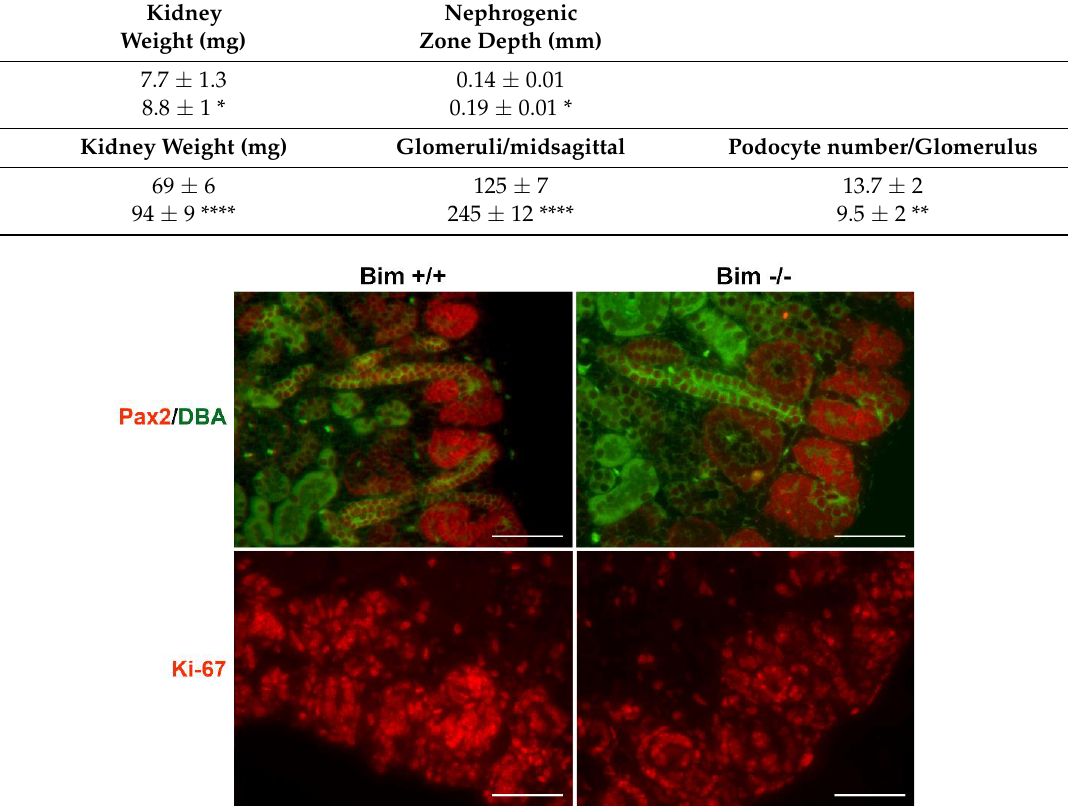
Figure 4. Glomular collapse in kidneys from P21 Bim −/− mice. Kidneys from P21 mice were stained with WT-1(red) to stain podocytes and Lycopersicon esculentum (green) to stain the vasculature. Data is representative of six mice. Scale bar is 100 µm. 3.3. Decreased Oxidative Stress in the Absence of Bim Our previous studies demonstrated increased oxidative stress in kidneys from Bcl-2 −/− mice. Since Bim typically acts in opposition to Bcl-2, here we asked whether the mito- chondrial redox ratio was affected in the absence of Bim expression. We have demon- strated that the normalized ratio of intrinsic mitochondrial fluorophores (NADH/FAD, the mitochondrial redox ratio) is a marker of the mitochondrial redox and metabolic state of tissue ex vivo and in vivo [20]. In Figure 5, cryo-fluorescence redox imaging shows kidneys from Bim −/− mice had decreased oxidative stress (higher redox ratio). This is consistent with Bim promoting apoptosis by negating the antioxidant effect of Bcl-2.